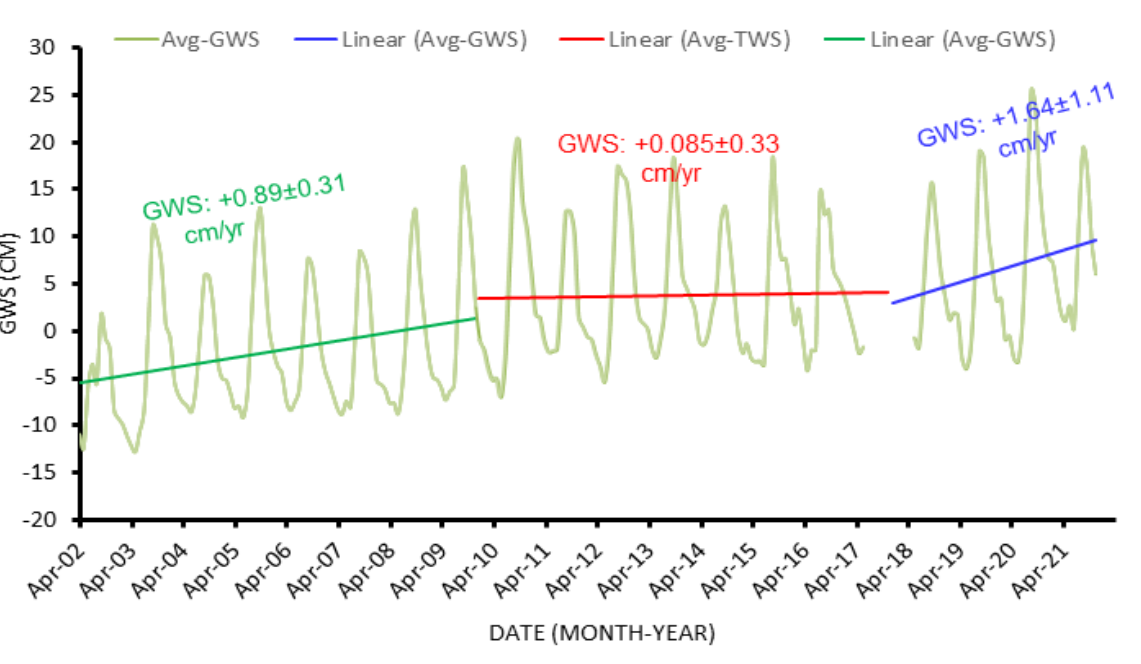
Figure 8. Monthly time series of the Avg-GWS over the study area during the three periods.